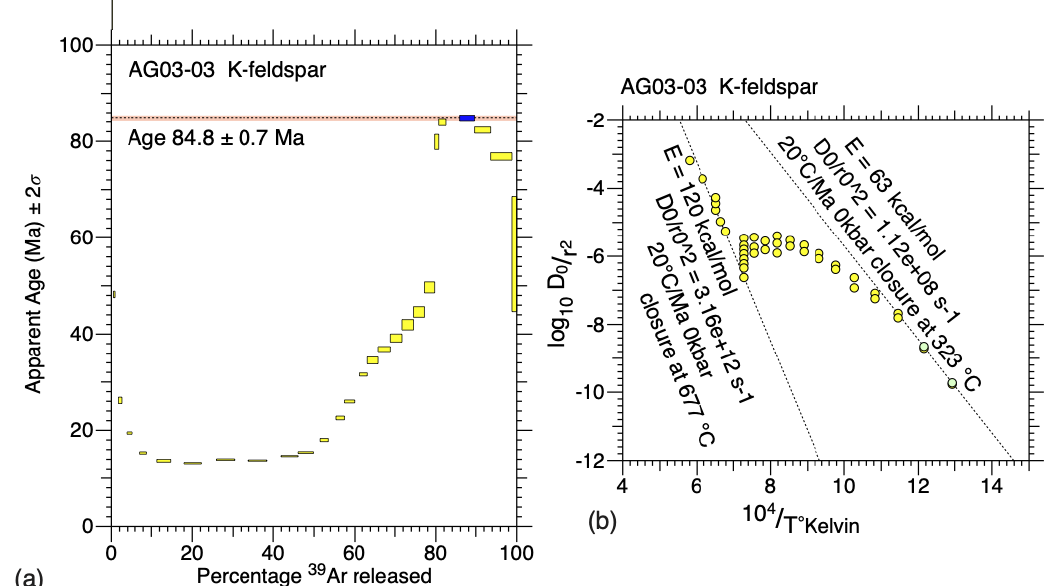
Figure 11. (a) A K-feldspar age spectrum from the structurally lowest augengneiss core (with isothermal cleaning steps removed). The origin of the younger part of the age spectrum is discussed by Forster and Lister (2009). The Late Cretaceous age is preserved in the retentive core domains. (b) The corresponding Arrhenius plot shows two diffusion domains with significantly different activation